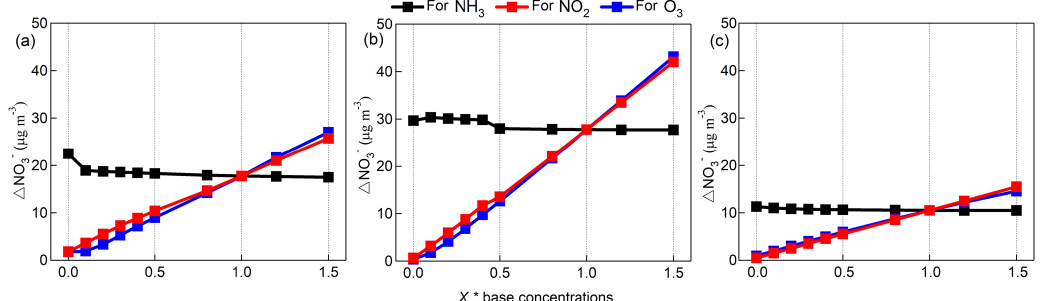
Figure 7. The same as Fig. 6 but for the nocturnal nitrate formation cases.